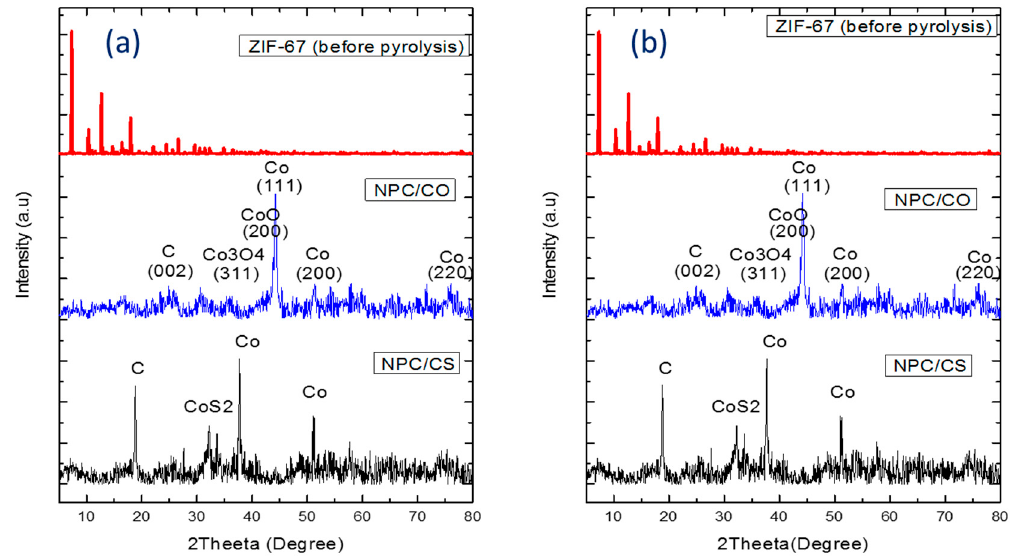
Figure 2. XRD patterns of ( a ) ZIF-67, NPC / CO and NPC / CS prepared in H2O and ( b ) ZIF-67, NPC / CO, and NPC / CS prepared in MeOH.